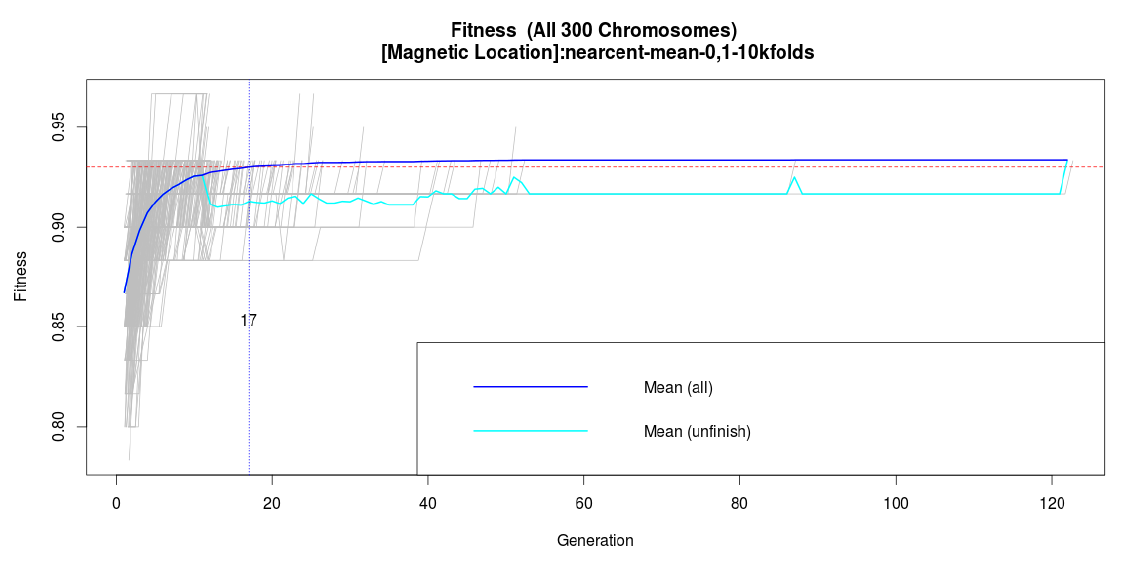
Figure 5. Fitness of the models through the evolutionary